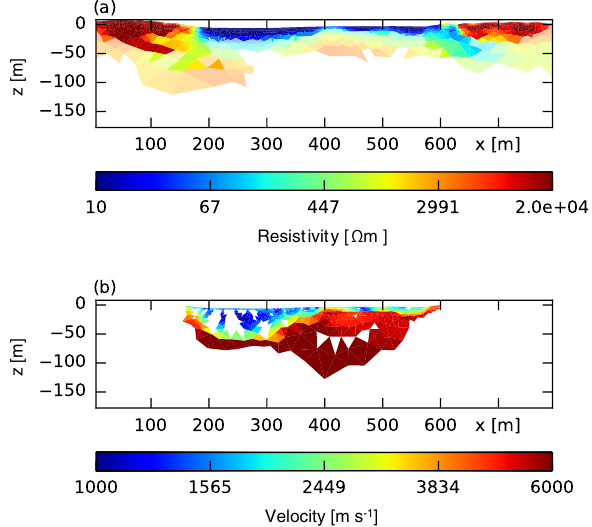
Figure 9. Joint inversion result with resistivity (top panel) and ve- locity (bottom panel) distribution. The shading is based on the cov- erage of each model cell. Figure 10. Cluster analysis of the joint inversion result using tree